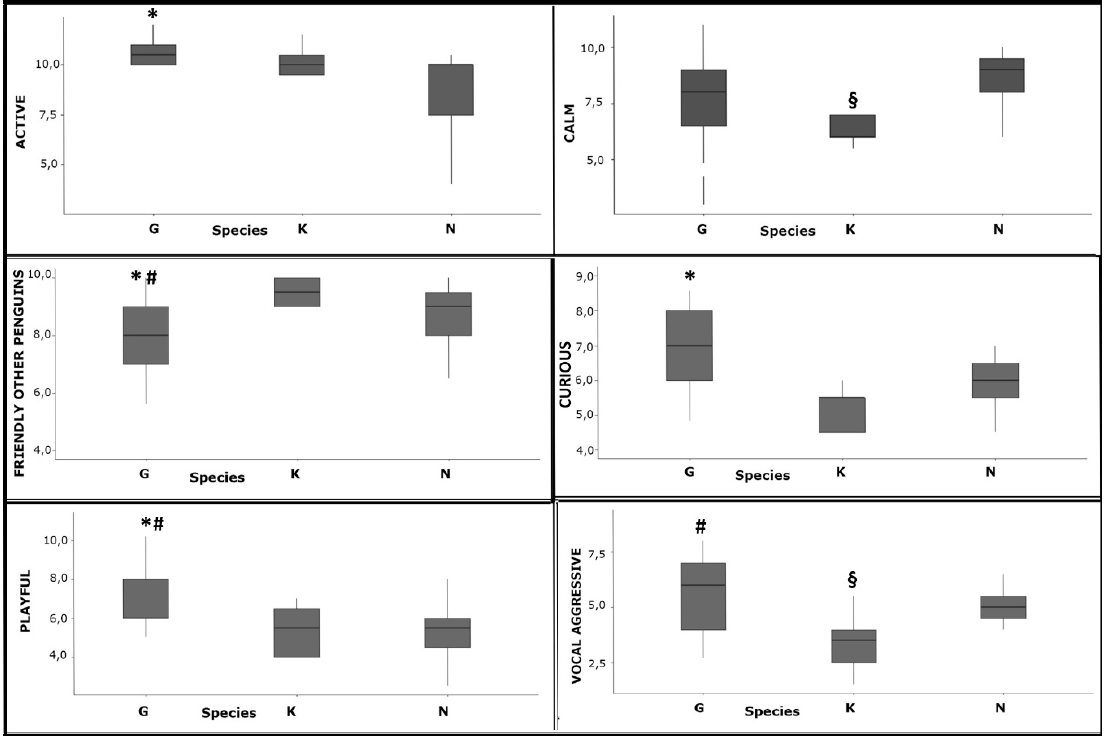
Figure 1. Box-whiskers plots for the statistically different personality traits in the 3 species considered (G = Gentoo penguins, K = King penguins, N = Northern rockhopper penguins), p < 0.05 values are considered as statistically different, * = Gentoo vs. northern rockhopper; # = Gentoo vs. king; § = King vs. rockhopper.